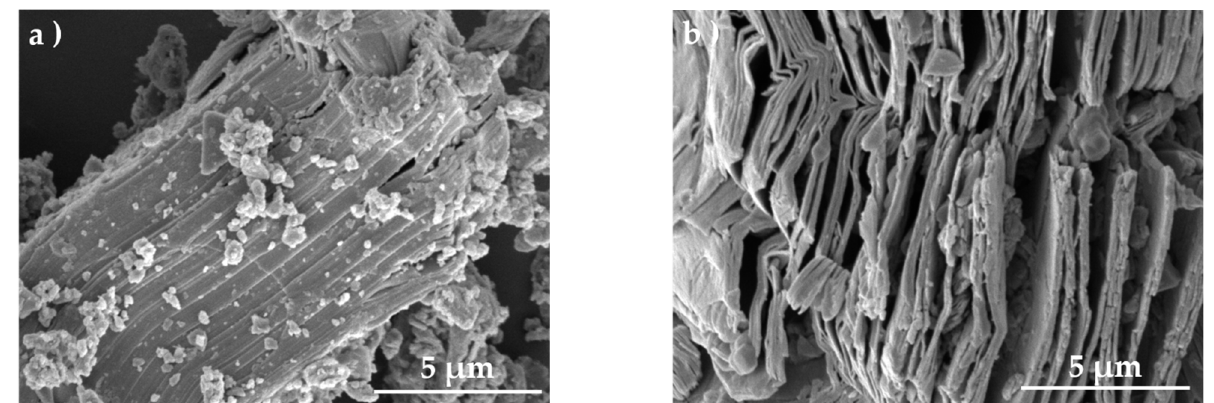
Figure 3. SEM images of ( a ) Ti 3 AlC 2 and ( b ) Ti 3 C 2 T x before and after etching.